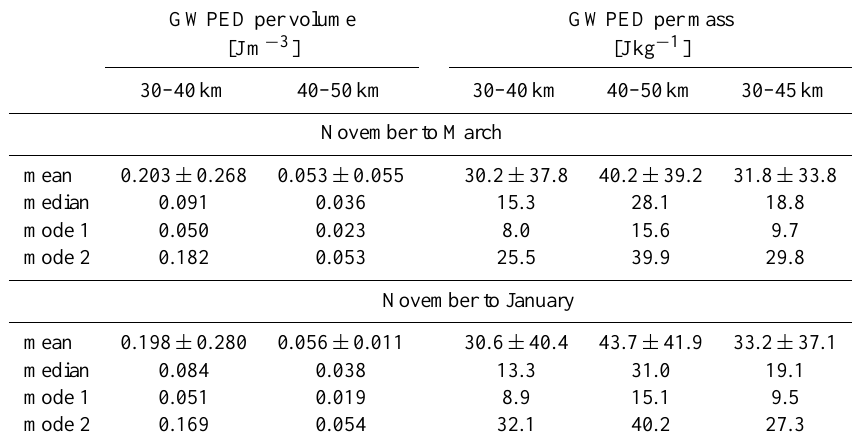
Table 3. Mean with standard deviation, median, and Gaussian mode values of GWPED for different altitude regions, derived from measure- ments with the Esrange